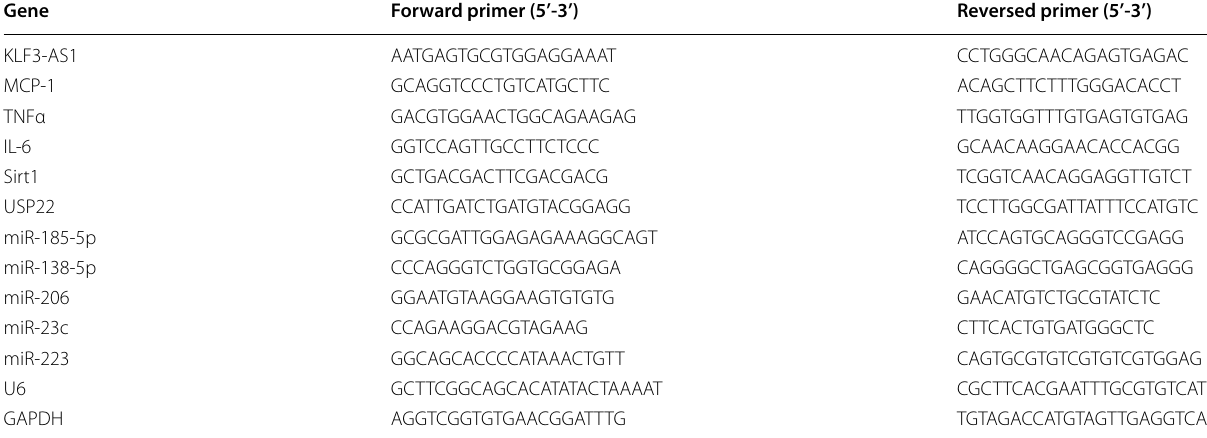
Table 1 The primer sequences used in qRT-PCR Gene Forward primer